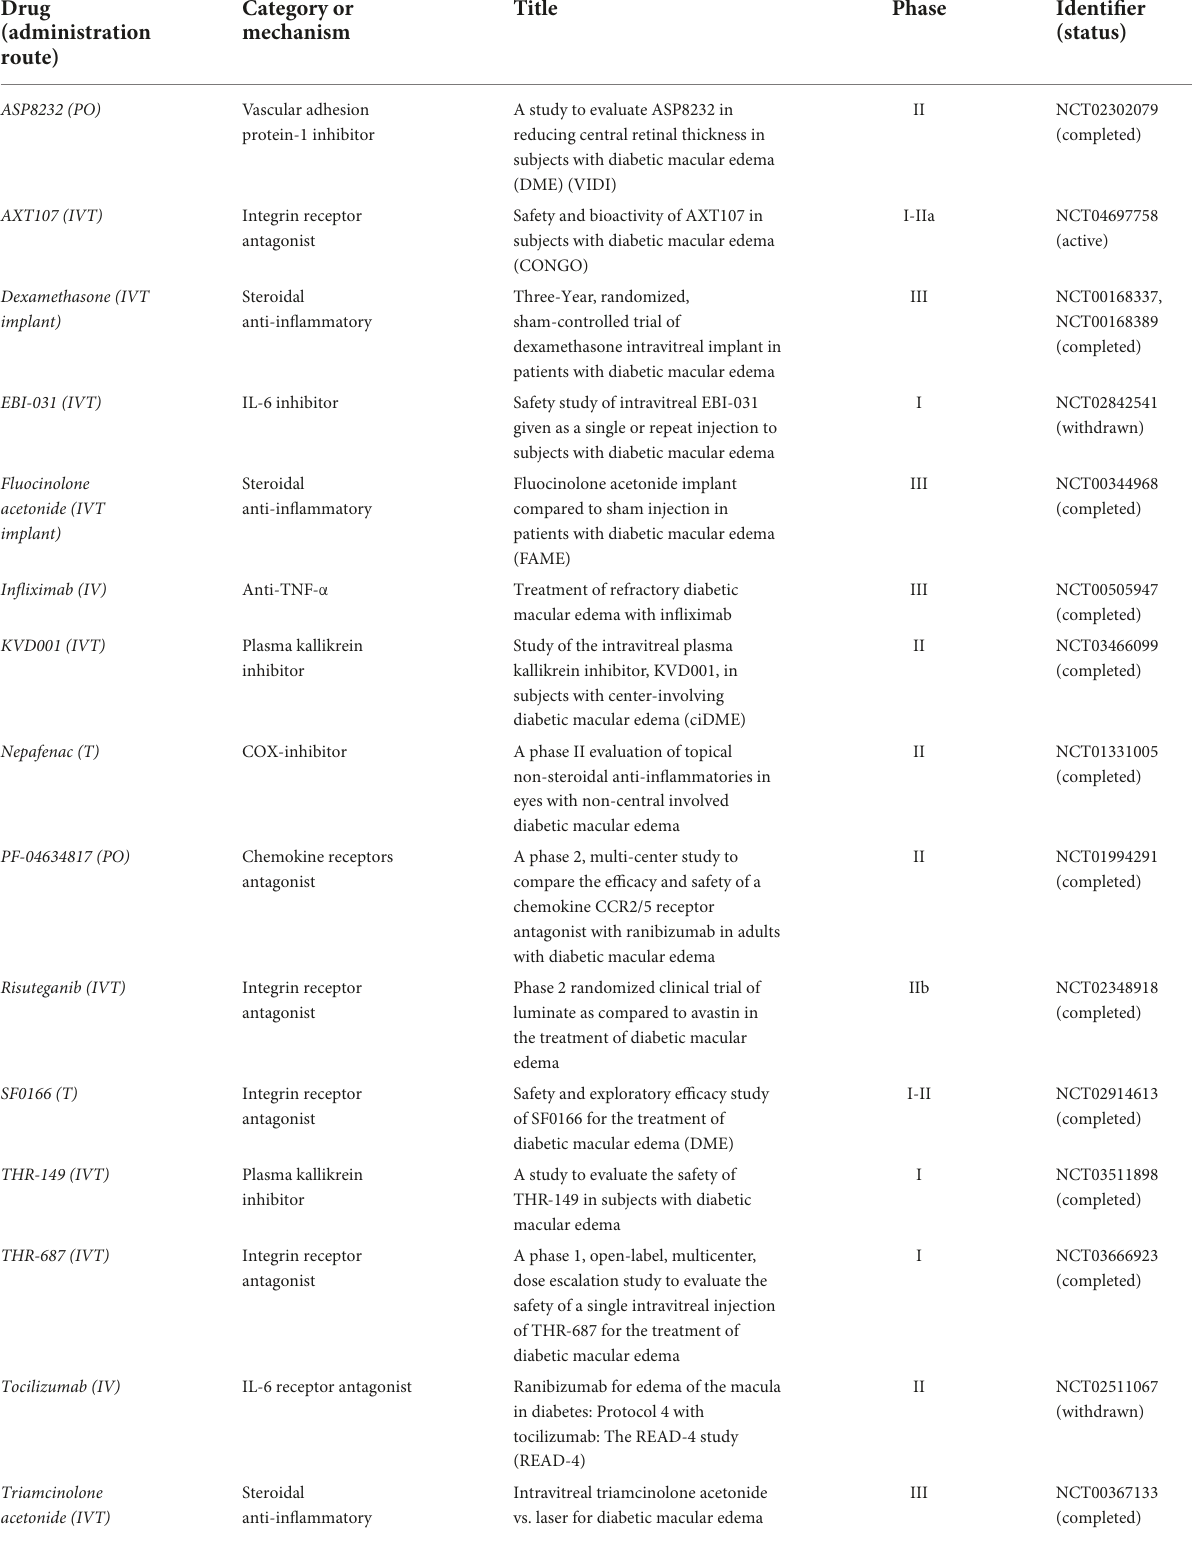
TABLE 2 Clinical trials on novel drugs targeting inflammation in diabetic